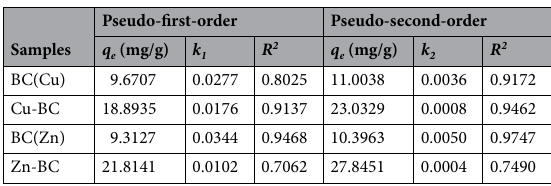
Table 6. Parameters of kinetic models of Cu 2+ and Zn 2+ .